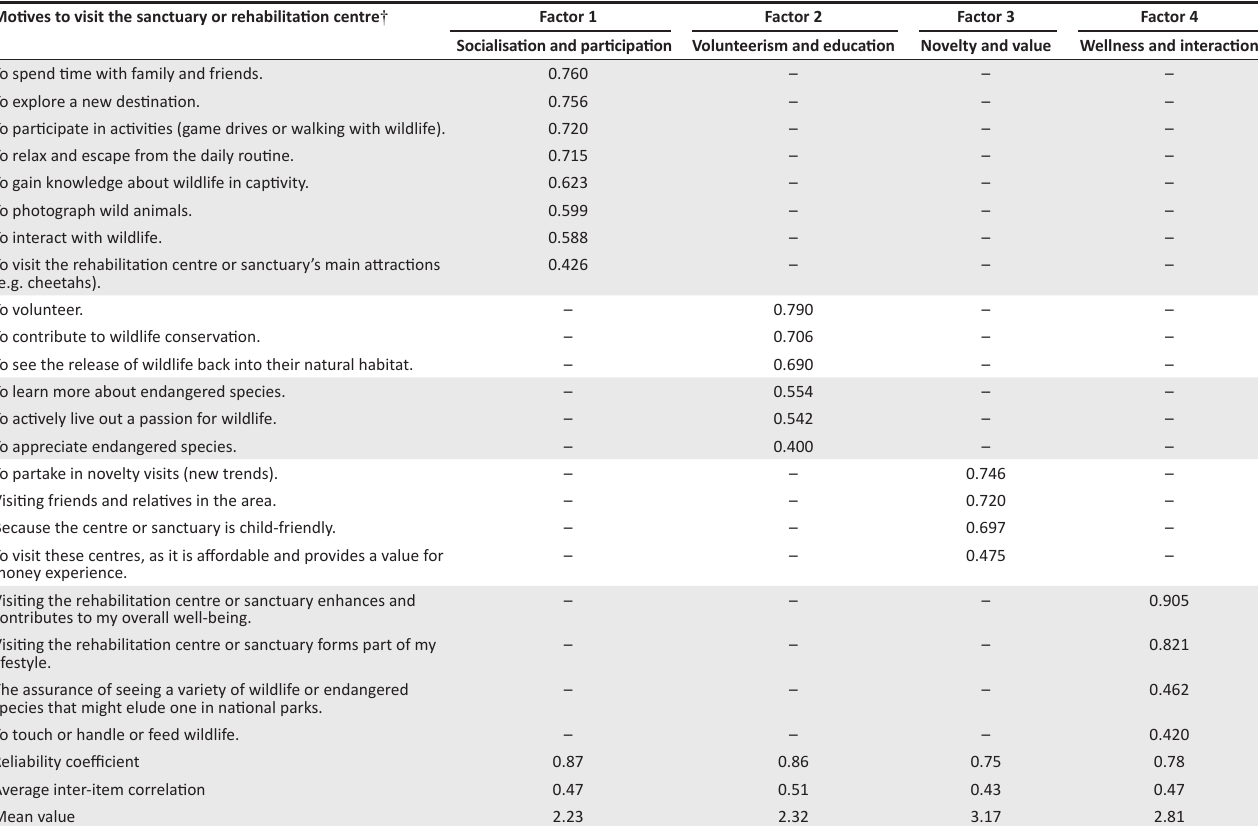
TABLE 4: Results of the exploratory factor analyses of the motivation to visit. Motives to visit the sanctuary or rehabilitation centre †